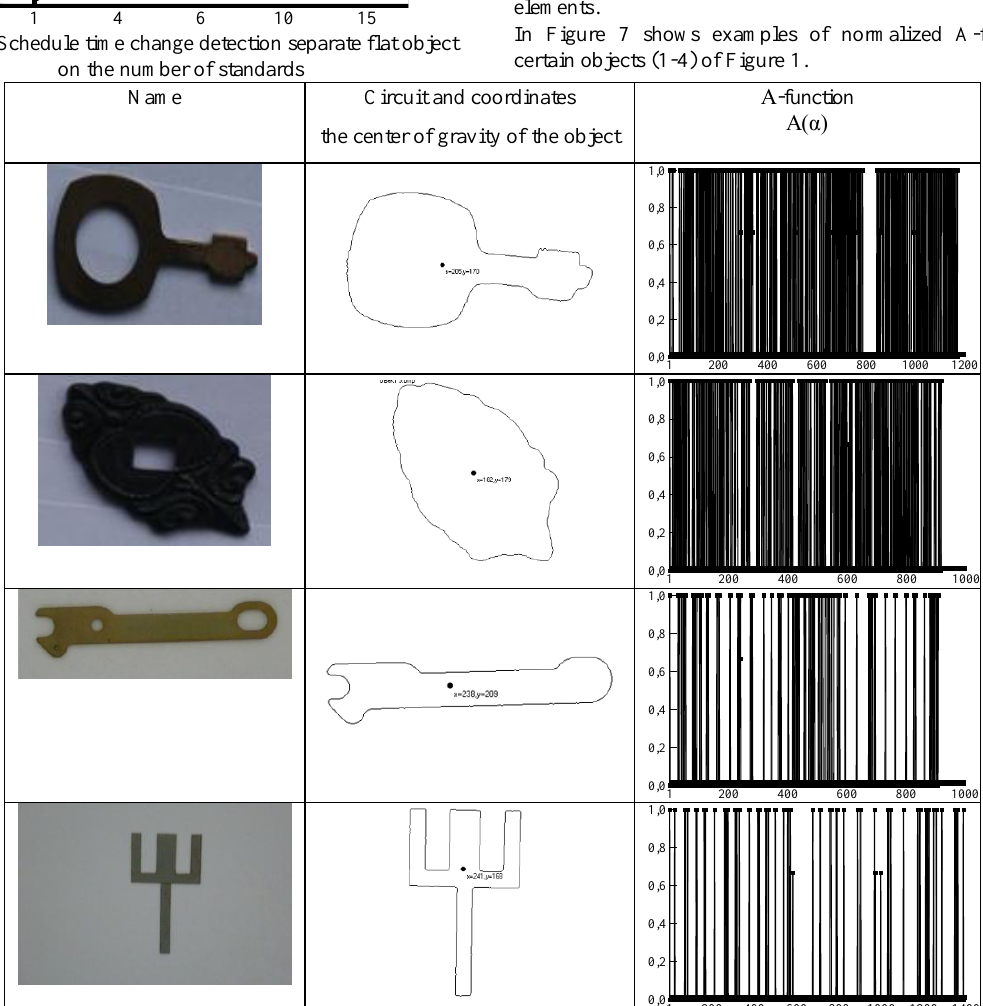
Figure. 6. Schedule time change detection separate flat object on the number of